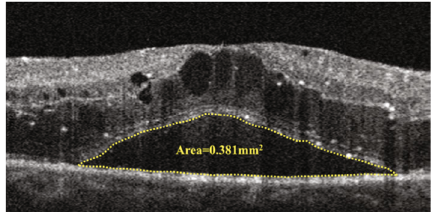
Figure 5: The area of subfoveal neuroretinal detachment was obtained by using the built-in AngioAnalytics software (calculated in the area of 3mm centered on the fovea) on B-scan passing through the center of the fovea at 0